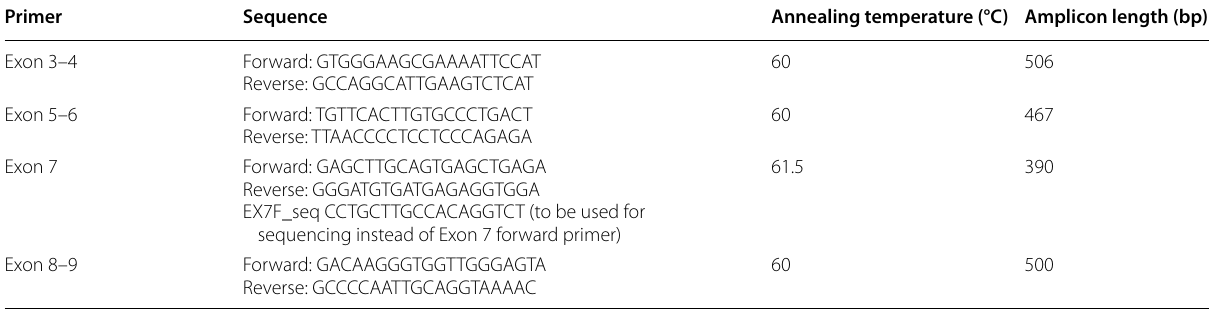
Table 3 Primers for polymerase chain reaction (PCR) amplification and subsequent P53 sequencing reactions